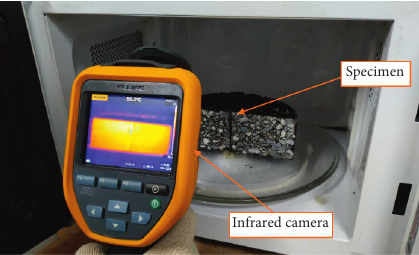
Figure 4: Microwave healing test